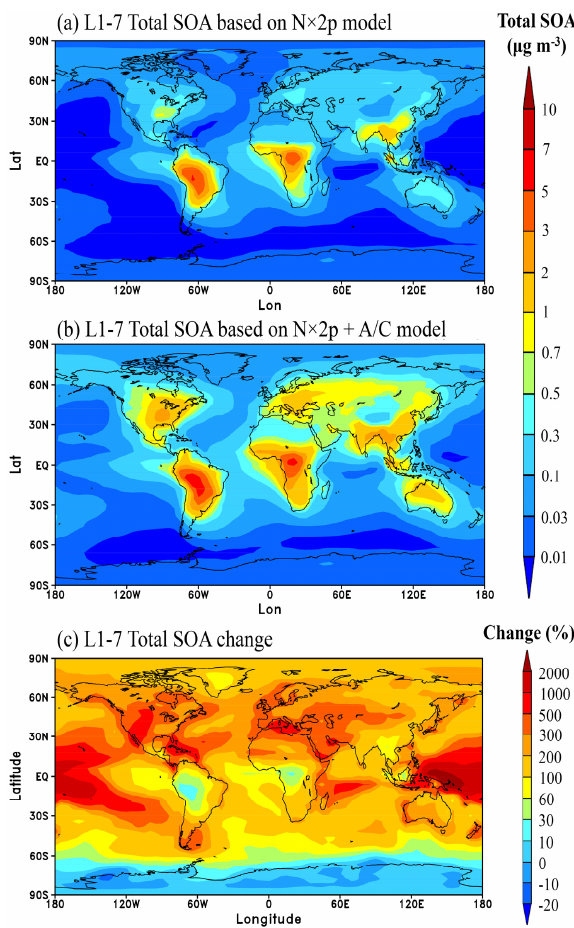
Figure 6. Fig. 6. Horizontal distributions of annual mean SOA mass con- centrations in the boundary layer (0–1km above surface) simu- lated (a) with original N × 2p SOA formation model, (b) with the N × 2p+A/C SOA formation model described in this paper, and (c) percentage increase in SOA mass when SOG oxidation aging and LV-SOG condensation are